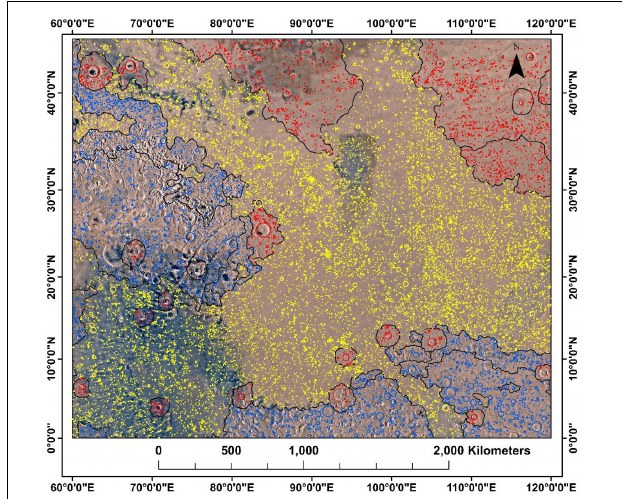
FIGURE 6 | Crater density map ( > 1.5 km) of the study area showing the Amazonian, Hesperian, and Noachian units as red-, yellow-, and blue-colored craters,